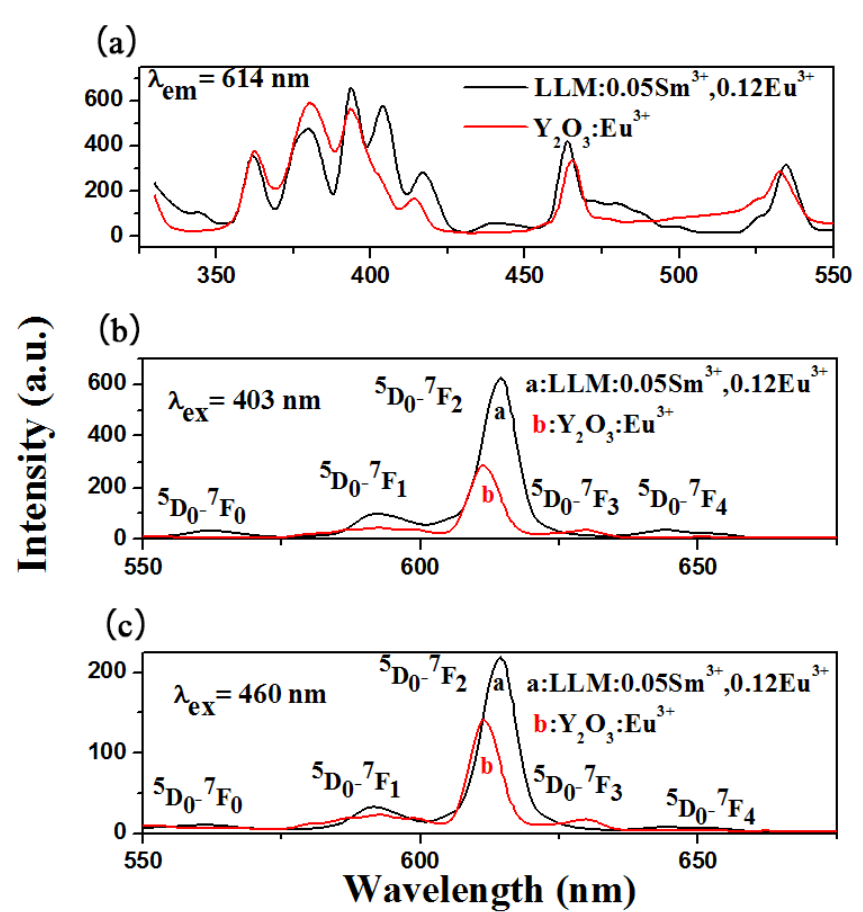
Figure 11. ( a ) The excitation spectra ( λ em = 614 nm); the emission spectra ( b ) ( λ ex = 403 nm) and ( c ) ( λ ex = 460 nm) of LL 0.83 M:0.05Sm 3+ ,0.12Eu 3+ and Y 2 O 3 :Eu 3+ .